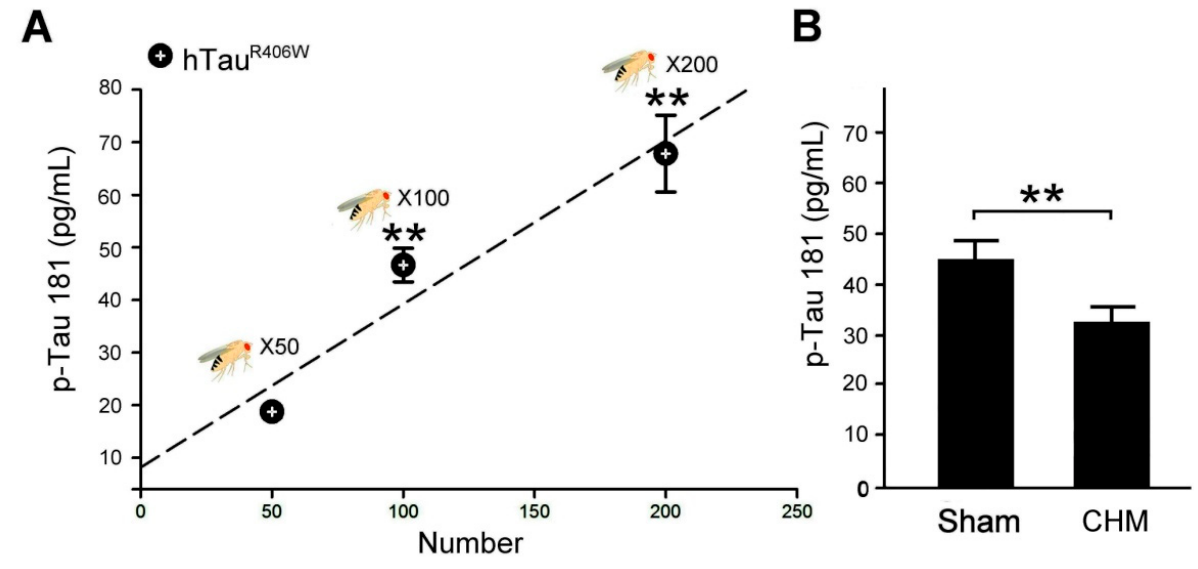
Figure 3. IMR can be a biosensor in therapeutic evaluation of Chinese herbal medicine for tauopathy alleviation in AD hTau R406W flies: ( A ) Relationship between the p-Tau 181 concentrations and the number of hTau R406W flies (sampled number = 50, 100, 200) obtained through IMR assay. ( B ) The diagram Quantified comparison of p-Tau 181 concentrations and IMR values in hTau R406W flies (sampled number = 100) under sham and Chinese herbal medicine (CHM) treatment (three replicate experiments for each group). Values are mean ± SEM (** p < 0.01, Kruskal–Wallis non-parametric test for multiple comparisons and followed by the Mann–Whitney non-parametric test for comparisons of two independent samples).